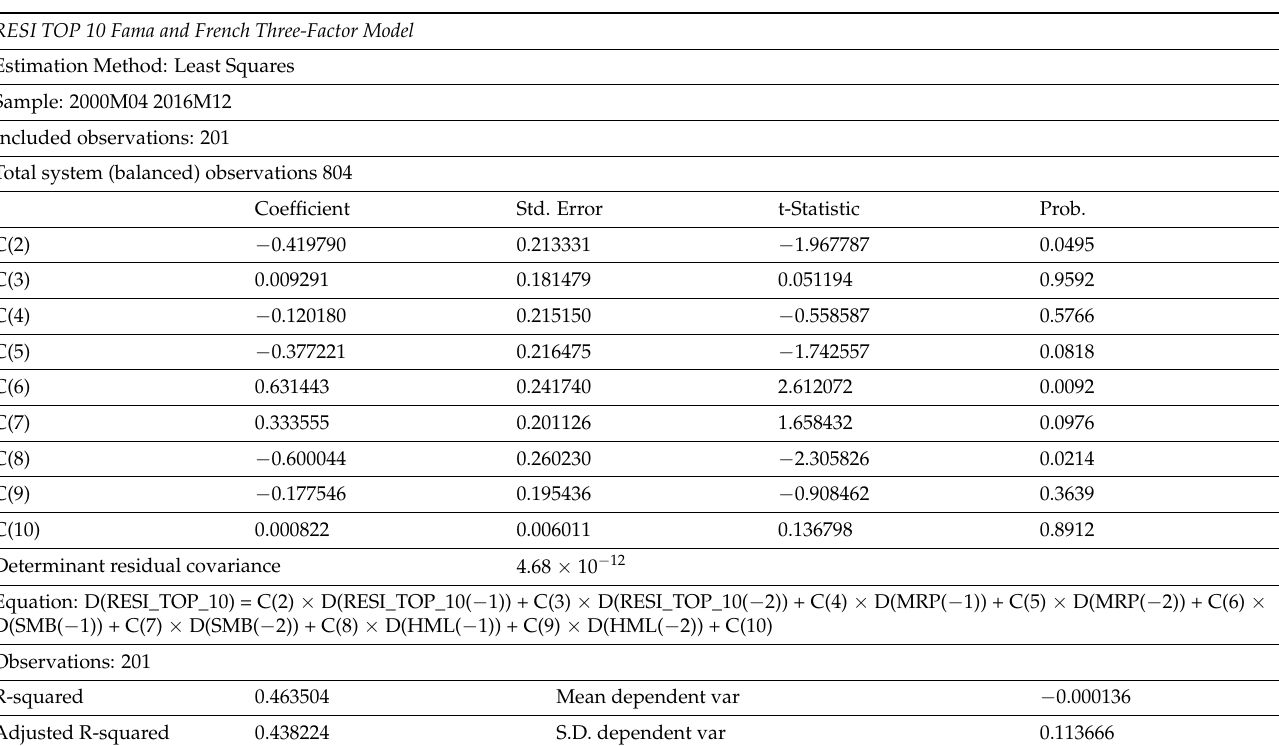
Table 5. Fama and French three-factor model